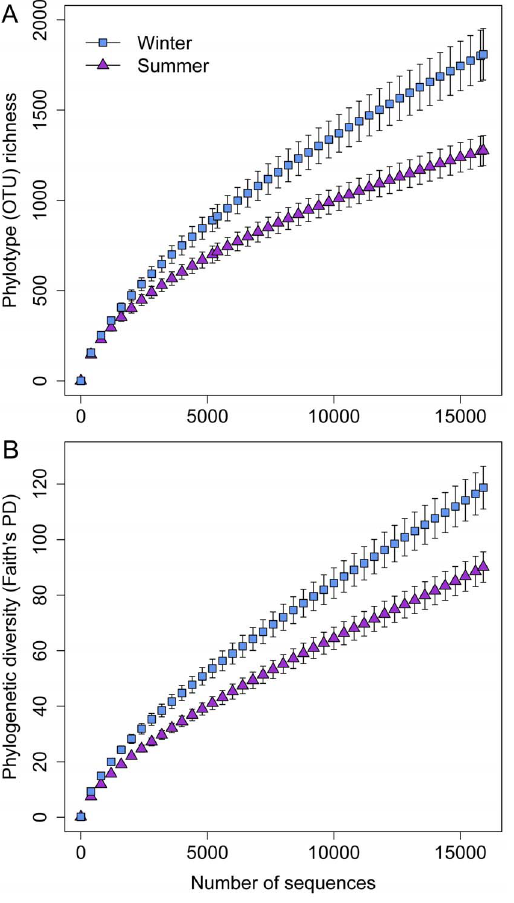
Figure 1. Rarefaction curves describing the bacterial OTU richness (A) and phylogenetic diversity observed in the bioaerosol of SCBs during the winter and summer seasons. Diversity indices were calculated using random selections of 15,909 sequences per sample and error bars represent + 1 s.e.m.